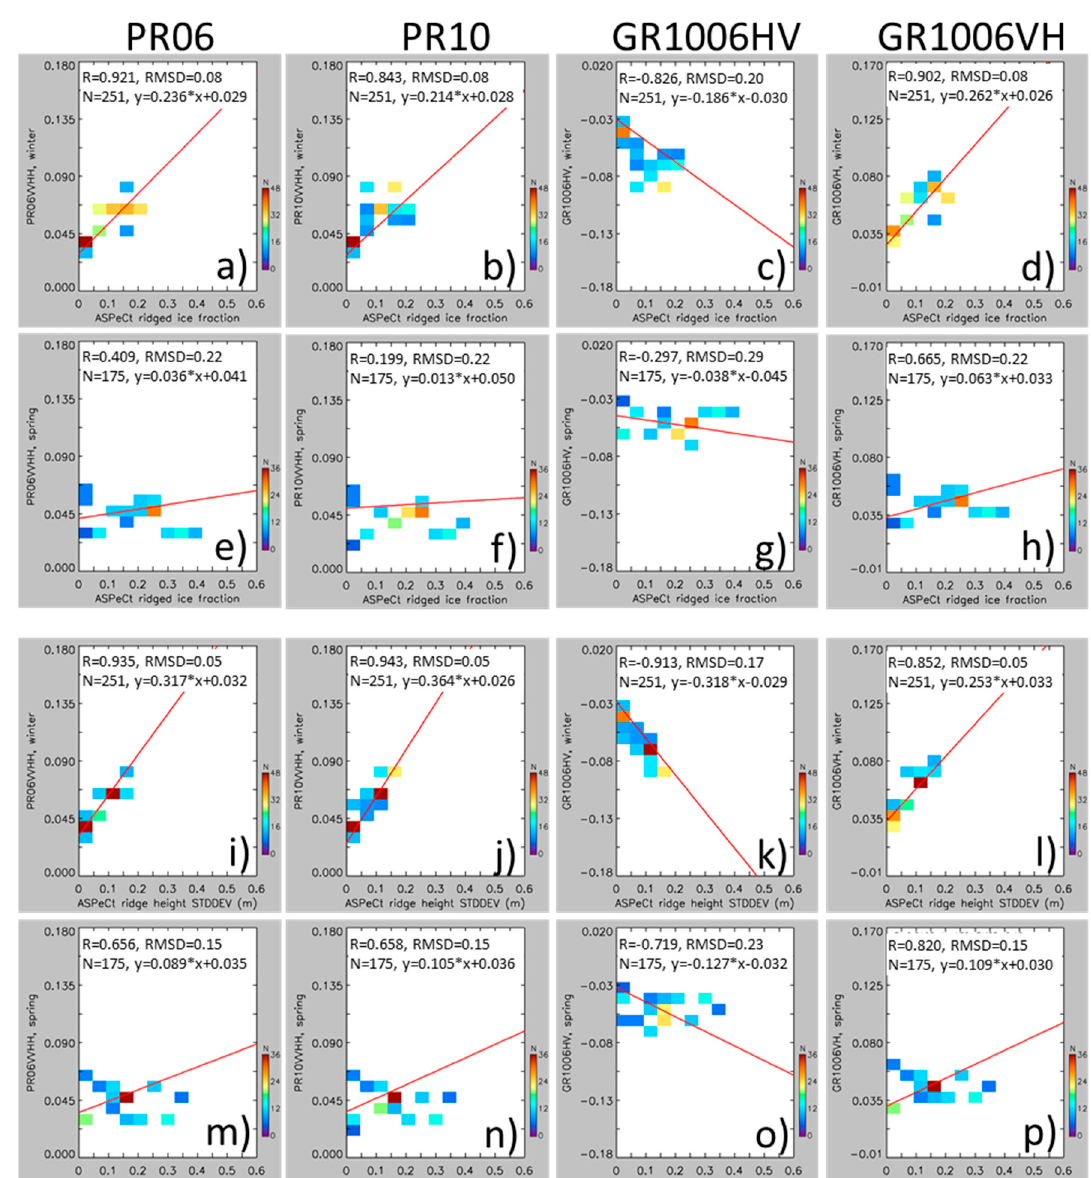
Figure 6. The two-dimensional histograms of the PR and GR values versus the ASPeCt topography parameters using the daily average values. Each color-coded square gives the count of data for the respective value pair. The red line denotes the linear regression, whose equation is given at the top in every panel together with the linear correlation coefficient R, the total number of data pairs N, and the root mean squared difference RMSD. Panels ( a – d ) and ( e – h ) show the ASPeCt ridged ice fraction for winter (June/July/August) and spring (September/October/November), respectively. Panels ( i – l ) and ( m – p ) show the ASPeCt ridged height standard deviation for winter and spring, respectively.